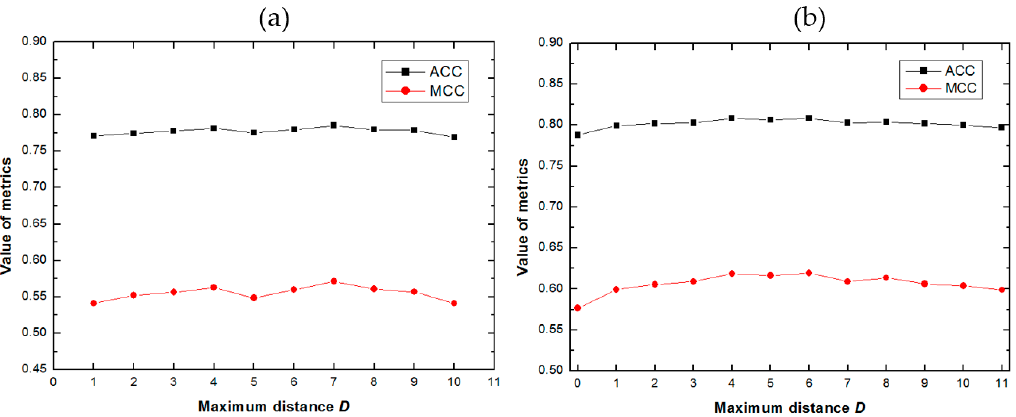
Figure 1. ( a ) The performance of Position Specific Frequency Matrix-Evolutionary Difference Transformation (PSFM-EDT) with different D on the benchmark dataset via five-cross validation. ( b ) The performance of Position Specific Frequency Matrix-Distance-Bigram Transformation (PSFM-DBT) with different D on the benchmark dataset via five-cross validation.